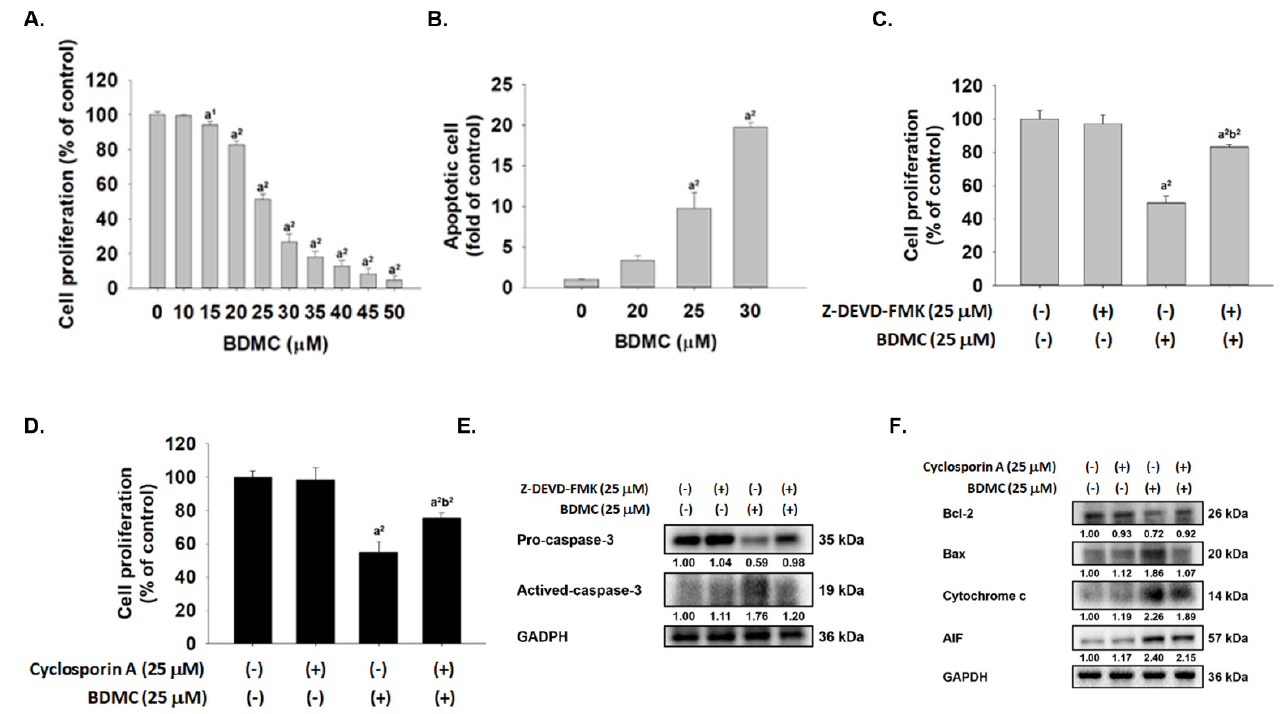
Figure 1. BDMC induced cytotoxic effect and cell apoptosis and affected apoptosis-associated protein expression in GBM 8401/ luc2 cells. Cells were placed in cell plates at the final density of 1 × 10 5 cells/mL for 48 h, and cells were treated with 0, 10, 15, 20, 25, 30, 35, 40, 45, and 50 µ M of BDMC for 48 h. After treatment, cells were harvested from each well for measuring cell proliferation ( A ) and apoptosis ( B ). Cells were pretreated with Z-DEVD-FMK (caspase-3 inhibitor) ( C ) and inhibitor of mitochondria membrane potential (cyclosporin A) ( D ) and were treated with 0 and 25 µ M of BDMC for 48 h and cell proliferation were determined. Cells were harvested for examining apoptosis-associated protein expression ( E , F ) by western blotting as described in Materials and methods. a 1 and a 2 significantly different at p < 0.05 and p < 0.01 vs. the control group. b 2 significantly different at p < 0.01 vs. the BDMC